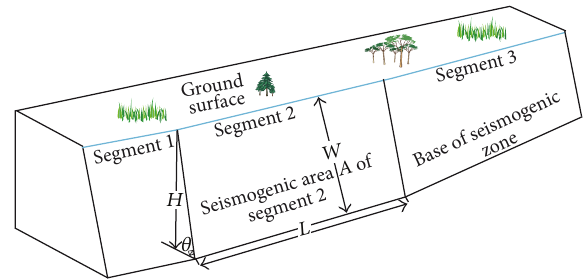
Figure 2: Conceptual illustration of a segmented oblique fault. Also shown are measures of length 𝐿 , down-dip width 𝑊 , epicenter depth 𝐻 , and dip angle 𝜃